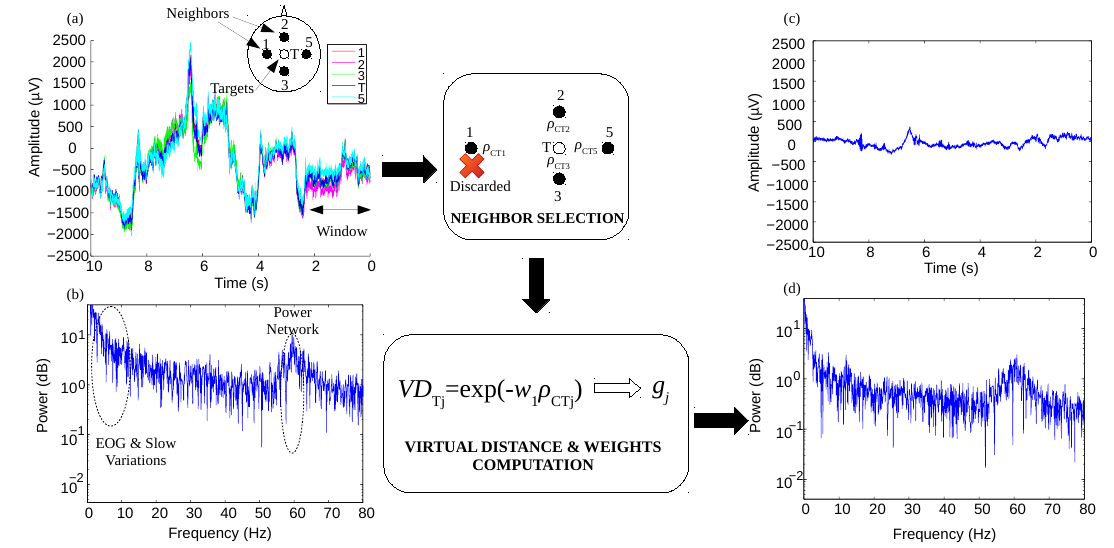
Figure 1. Block diagram of the proposed adaptive filter for EEG signals. Signals acquired around Cz (target electrode, T) during a cycle of gait, with processing through Ad LAR-small setup. ( a ) raw EEG signals; ( b ) power spectrum on T location using Fast Fourier Transform (FFT); ( c ) filtered signal from the location T; ( d ) power spectrum of the filtered signal using FFT showing an attenuation on components of low frequency ( ≤ 10 Hz) and 60 Hz (power